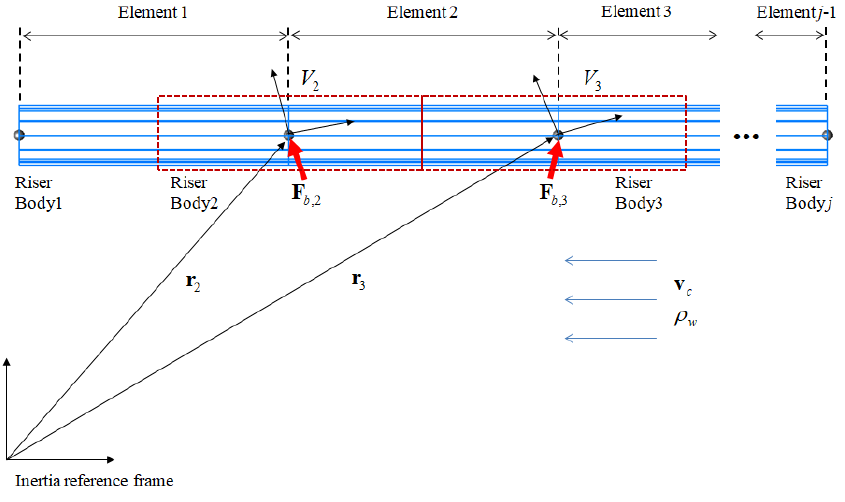
Figure 8. Buoyancy and kinematic relationships in the riser system.